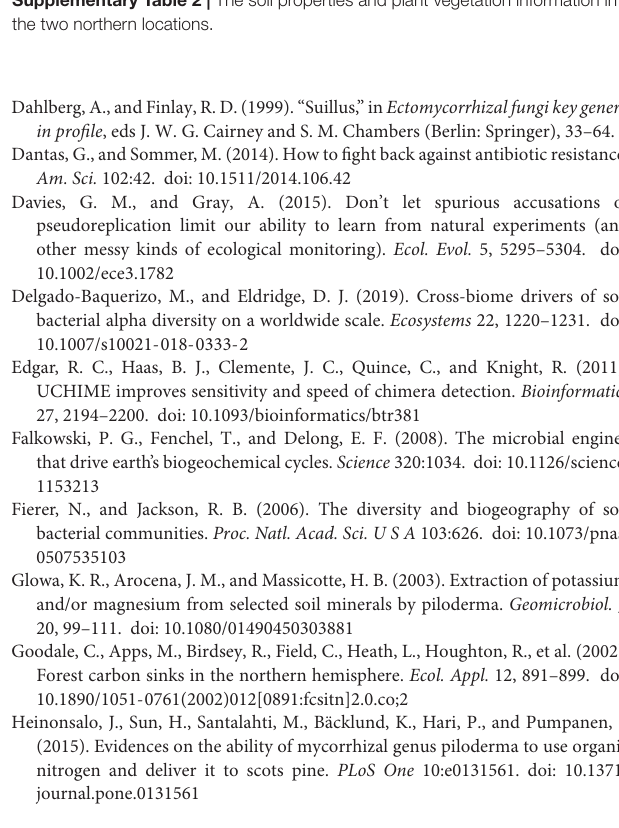
Supplementary Figure 1 | Rarefaction curve showing the sequence depth and observed OTUs. Supplementary Figure 2 | Pie chart showing the overall distribution of fungal sequences ( n = 186,138) at the phylum level across the three locations in boreal pine forests. Supplementary Table 1 | The basic information on the sites in the three locations. Supplementary Table 2 | The soil properties and plant vegetation information in the two northern